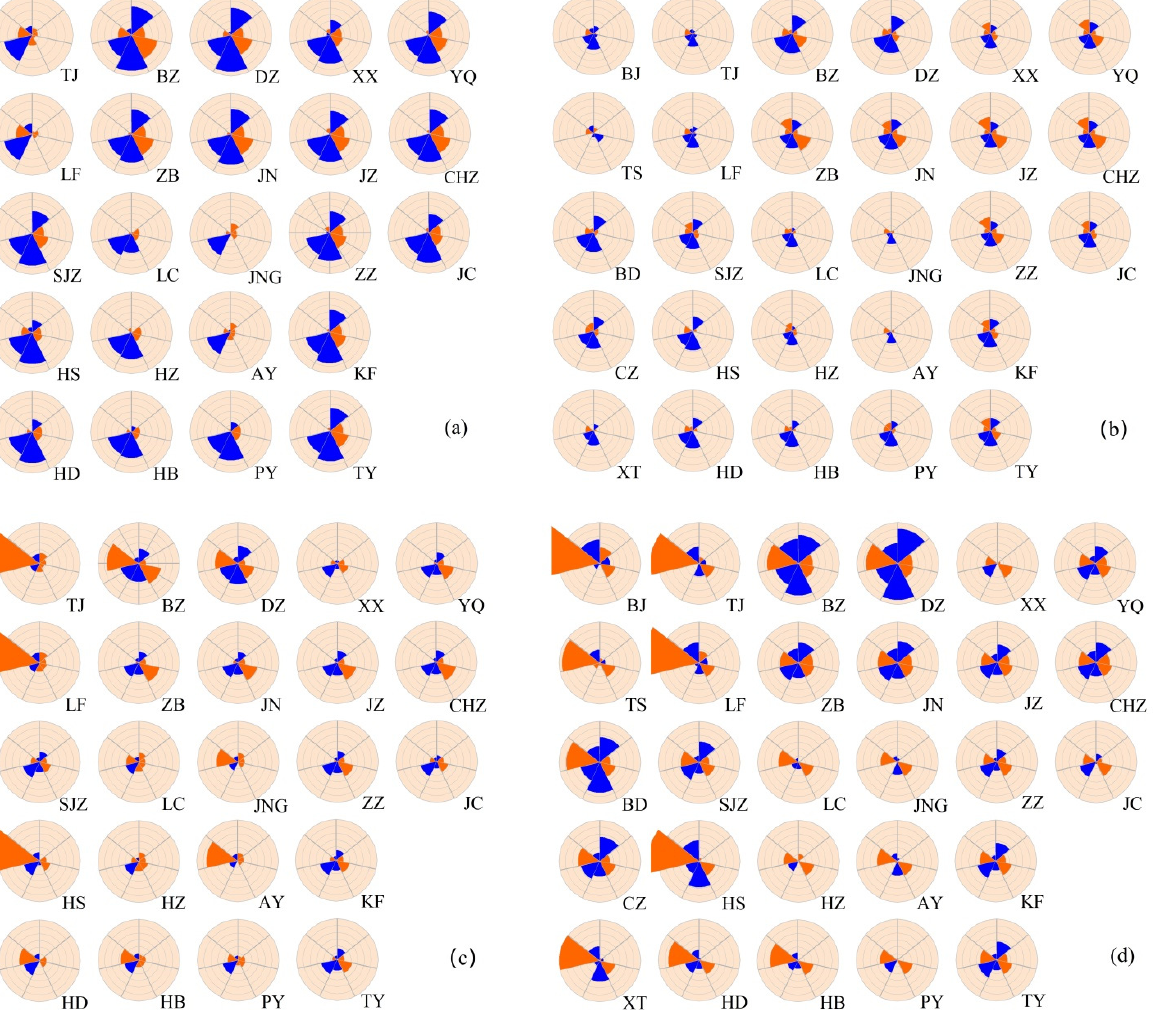
Figure 7. The influence characteristic of meteorological factors for each city based on regression coefficients derived from GWR at the seasonal scale. ( a ) Spring; ( b ) Summer; ( c ) Autumn; ( d ) Winter. Blue and orange indicate positive and negative spatial correlations, respectively, between mean PM 2.5 concentration and meteorological variables. Annuli from the center outward represent the magnitude of the regression coefficient, from lowest to highest. See Figure 7 for legend: BJ, Beijing; TJ,